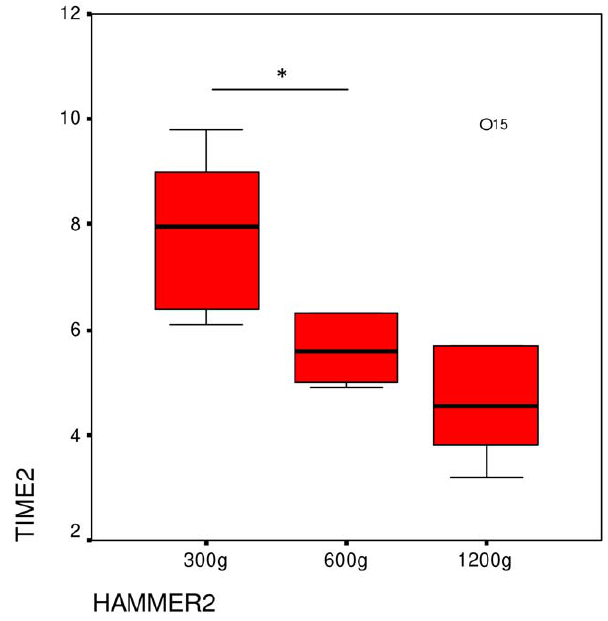
Figure 5. Median number of strikes needed to crack a nut in Experiment 2. Also shown are the IQR and significance tests.